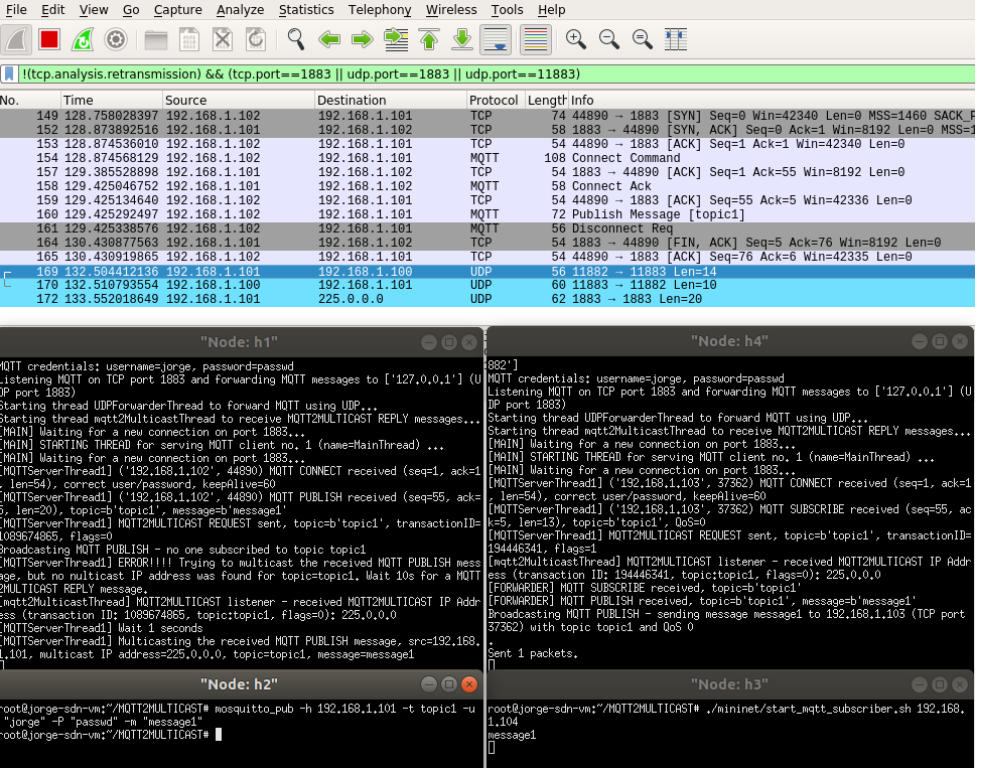
Figure 10. Operation of MQTT proxies on edge